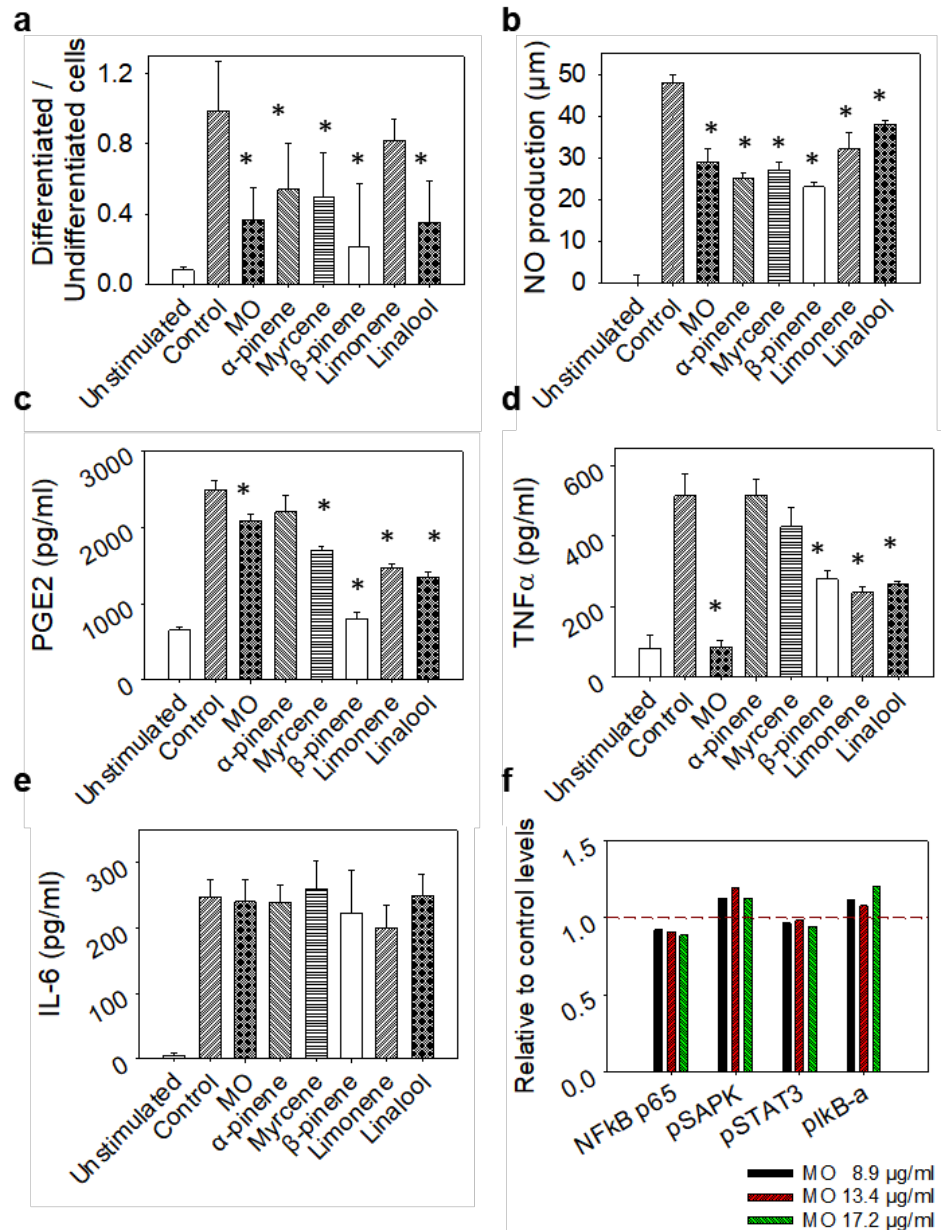
Figure 4. Effect of non-toxic concentrations of MO or its major constituents on LPS-stimulated RAW264.7 murine macrophages after 24 h of treatment. Control cells were only treated with LPS, while unstimulated cells were grown in plain medium (DMEM). ( a ) Ratio of differentiated to undifferentiated cells analysed by bright field microscopy. ( b ) NO levels in cells´ supernatant determined by the Griess assay. ( c ) PGE2, ( d ) TNF- α and ( e ) IL-6 levels in supernatants determined by ELISA. Results are presented as mean ± SD values of three replicates. ( f ) NFkB p65, pSAPK, pSTAT3 and pIkB-a levels determined by ELISA, in LPS-stimulated RAW264.7 macrophages treated with increasing concentrations of MO. Results are expressed as a relative to control ratio. Dashed line indicates normalised control levels as reference. Data shown are representative of three independent experiments. Asterisks indicate statistically significant difference compared to control (one-way ANOVA, p ≤ 0.05 ).